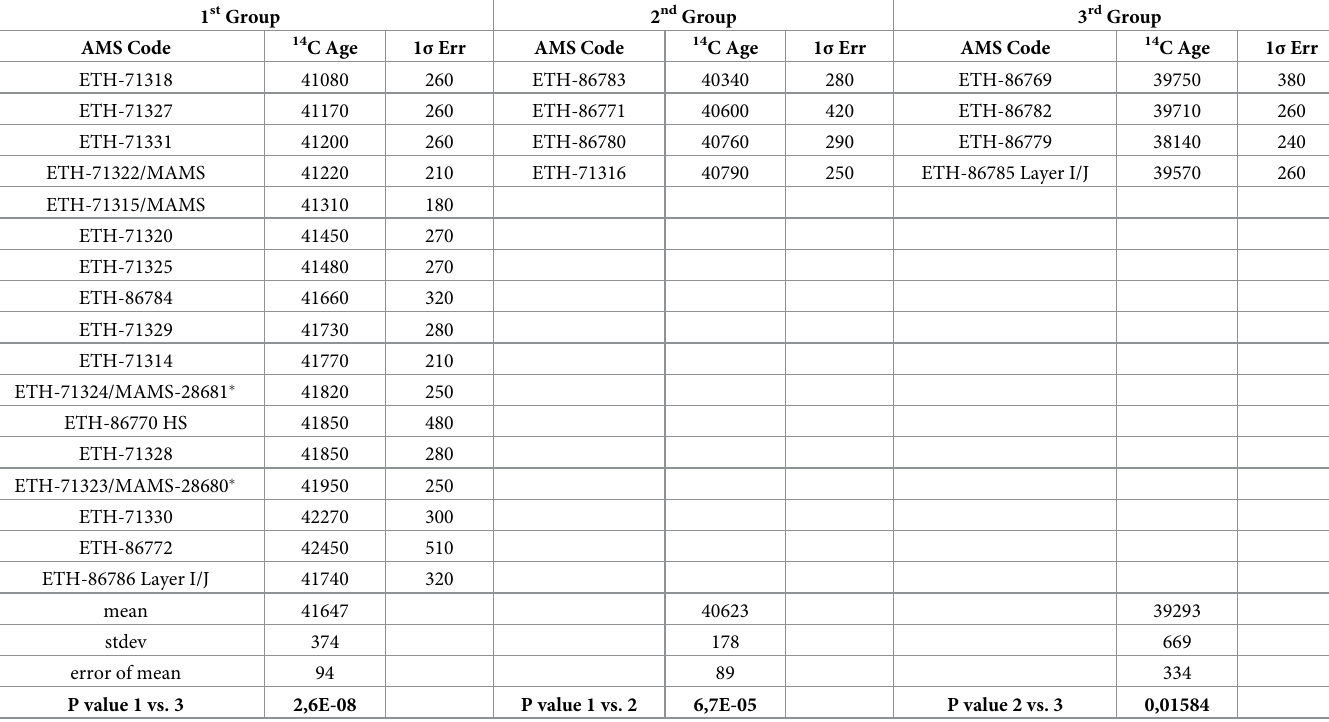
Table 2. T-test values of the 3 different groups of the dates in layer N1-I from [35]. The dates in red are the Homo sapiens directly dated. 1 st Group 2 nd Group 3 rd